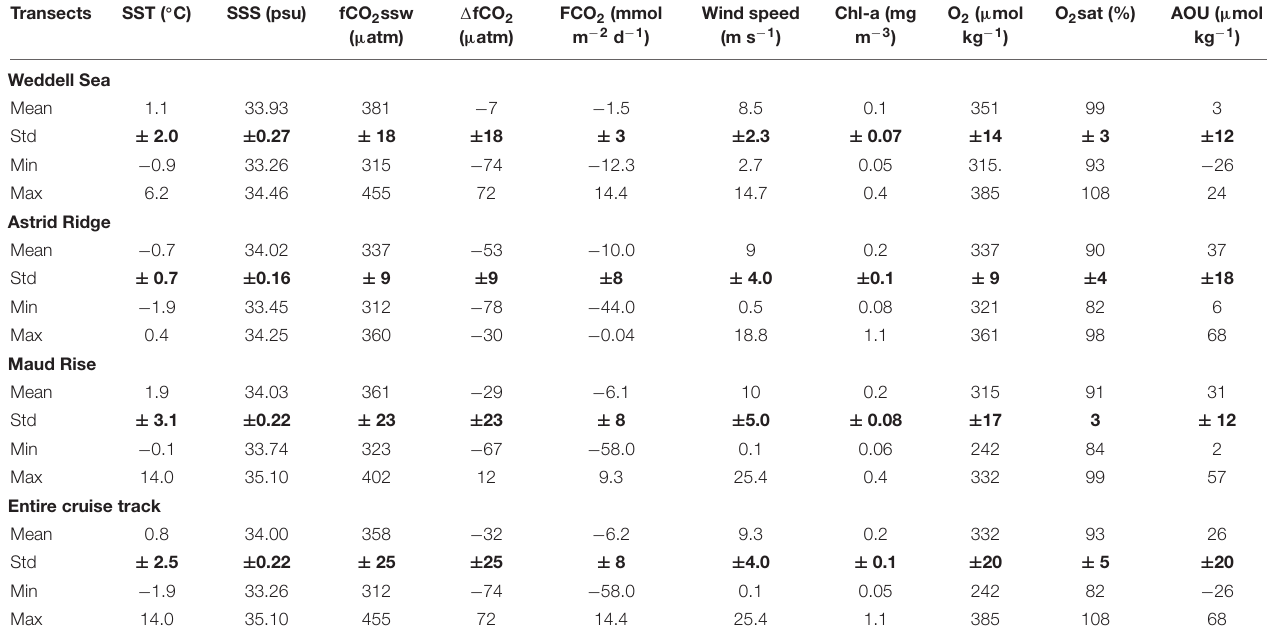
The standard deviation values in bold. ( Table 2 ). SST varied widely over the WS and MR